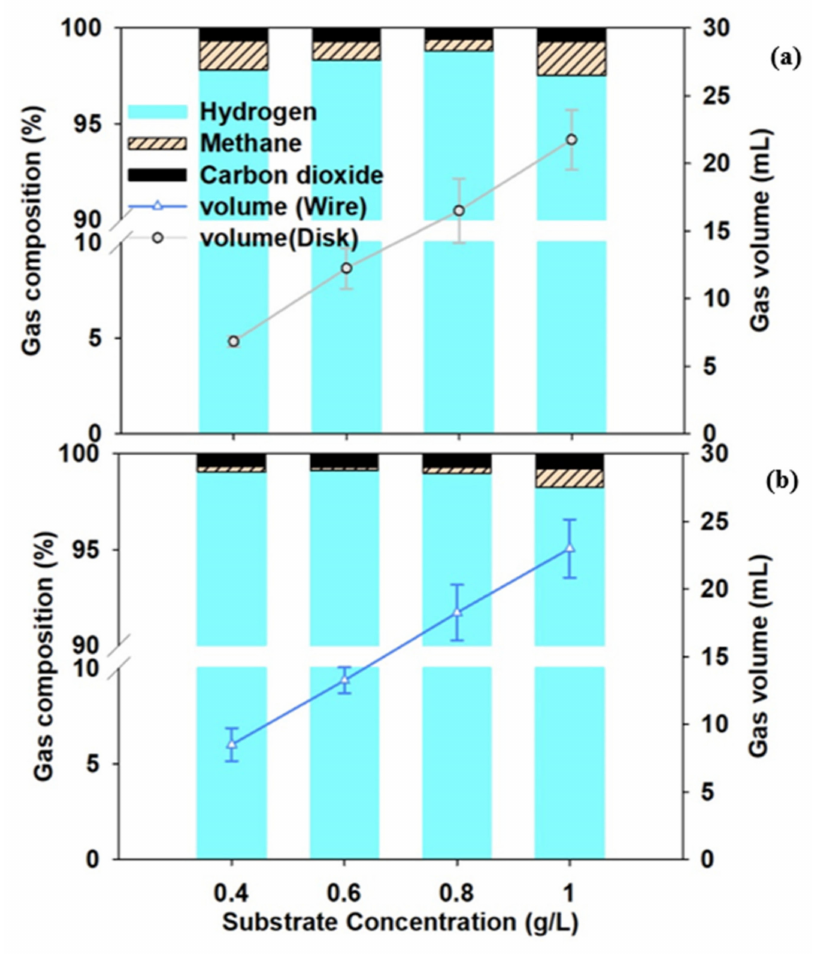
Figure 4. Total gas generation and gas compositions with different cathode types: ( a ) disk electrodes and ( b ) wire